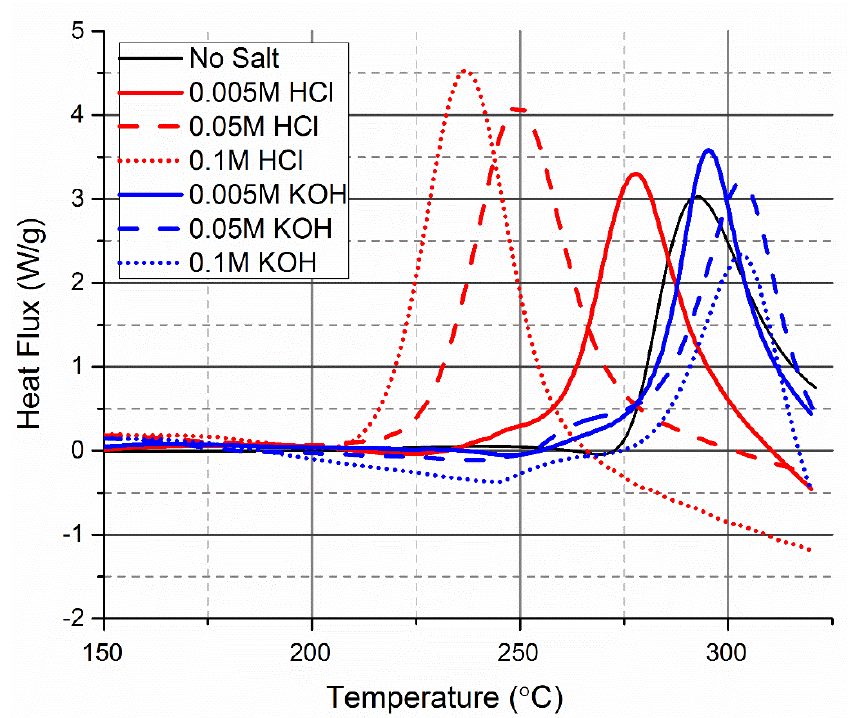
Figure 3. The effect of pH on the HTC of cellulose measured by DSC. pH was decreased or increased with the addition of HCl and KOH, respectively.